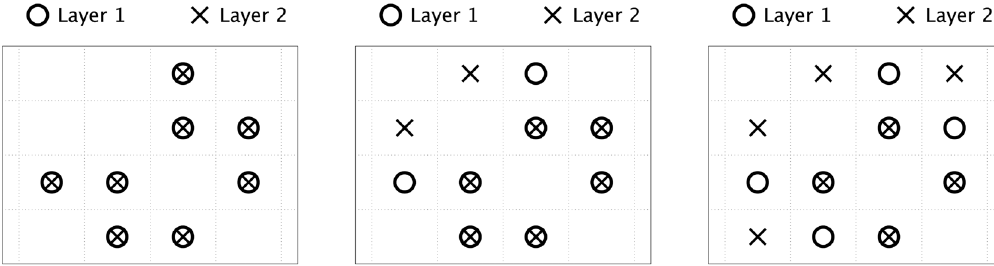
FIG. 15. Scenario 6. Adjacency matrices of each layer for three cases: (i, left panel) No rewiring takes place, and both layers are identical; (ii, middle panel) one edge has been rewired; (iii, right panel) two edges have been rewired. The transition matrices for each A =k case are T , where k is the degree of node i ij ¼ ij i i